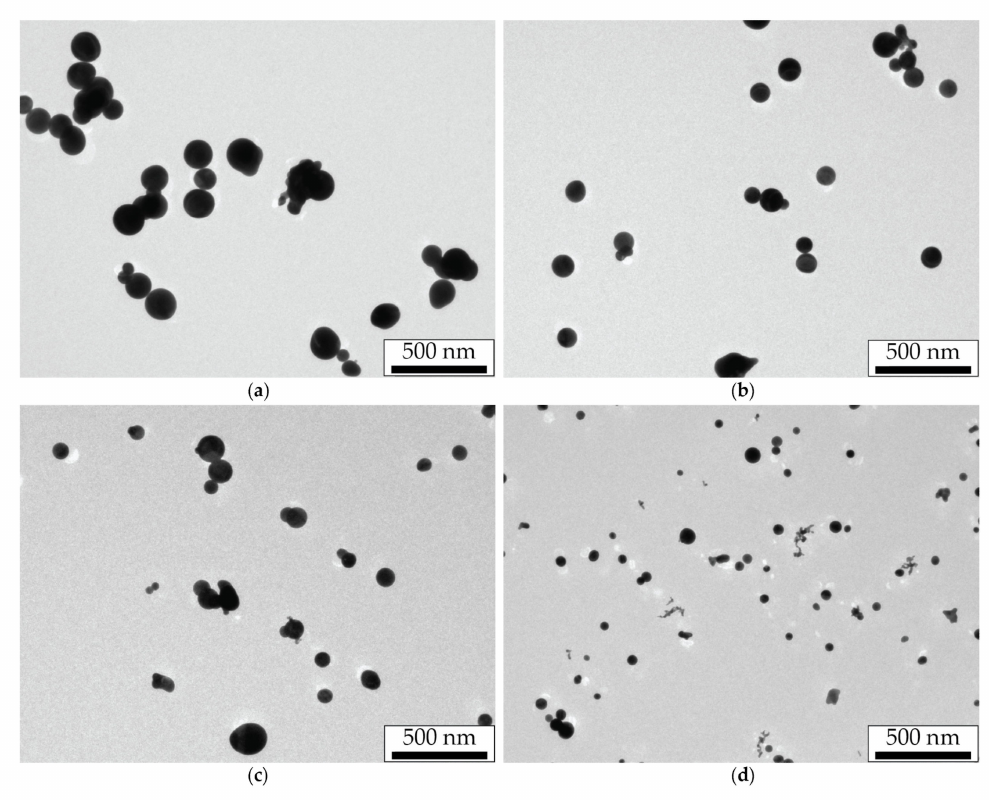
Figure 6. TEM images of gold NPs modified by laser radiation with the wavelength of 1053 nm at the pulse repetition frequency of 500 Hz with the pulse energy of 900 µ J and the aerosol flow rates of ( a ) 50, ( b ) 100, ( c ) 200, and ( d ) 400